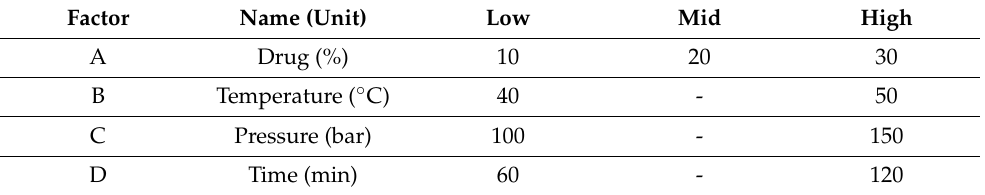
Table 4. Experimental design for the preparation of Simvastatin–Soluplus solid dispersions via scCO 2